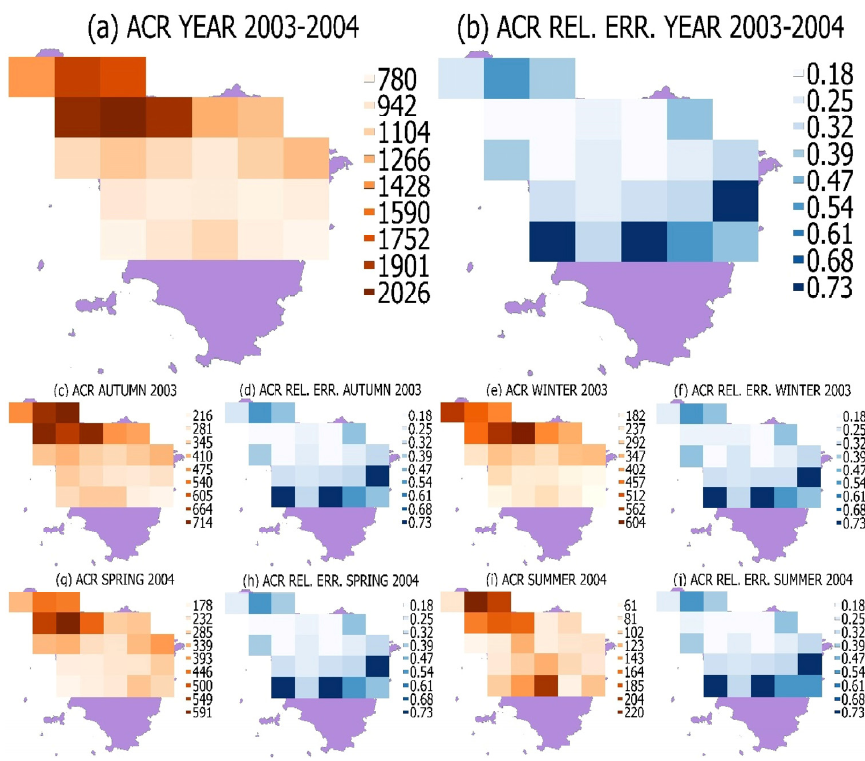
Figure 4. Annual ( a ) and seasonal ( c , e , g , i ) ACR (mm) and their relative errors ( b , d , f , h , j ), for all areas, year: 2003–2004.